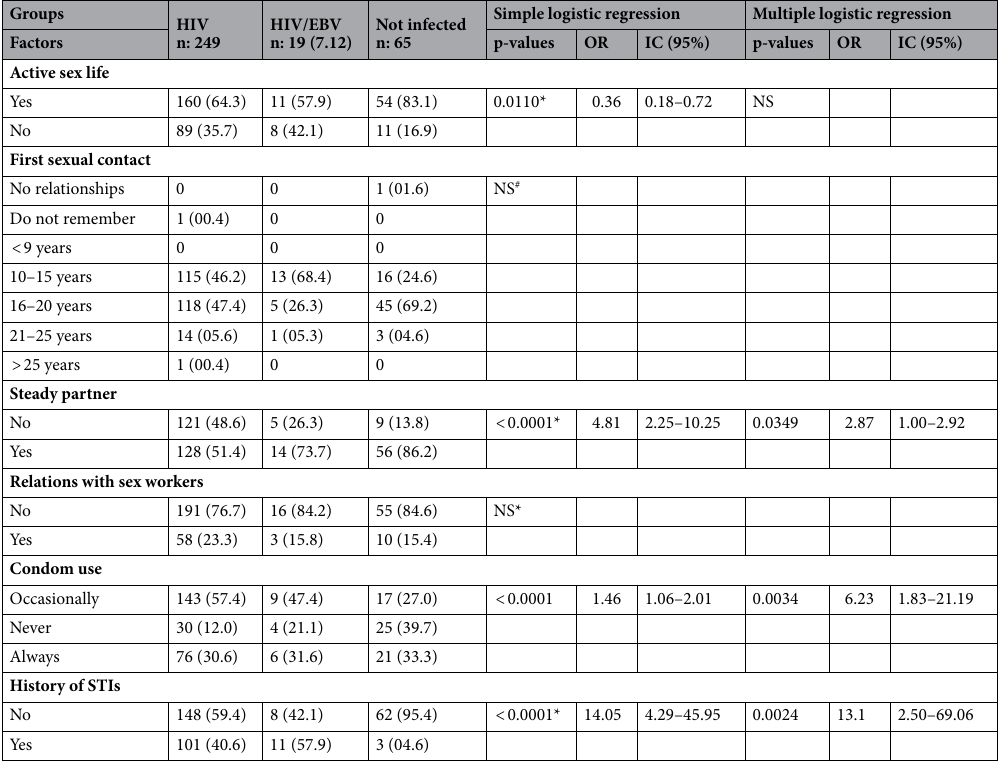
Table 1. Description of socio-epidemiological aspects and risk factors associated with HIV/EBV co-infection. NS: not significant; *Fisher’s exact test; # G